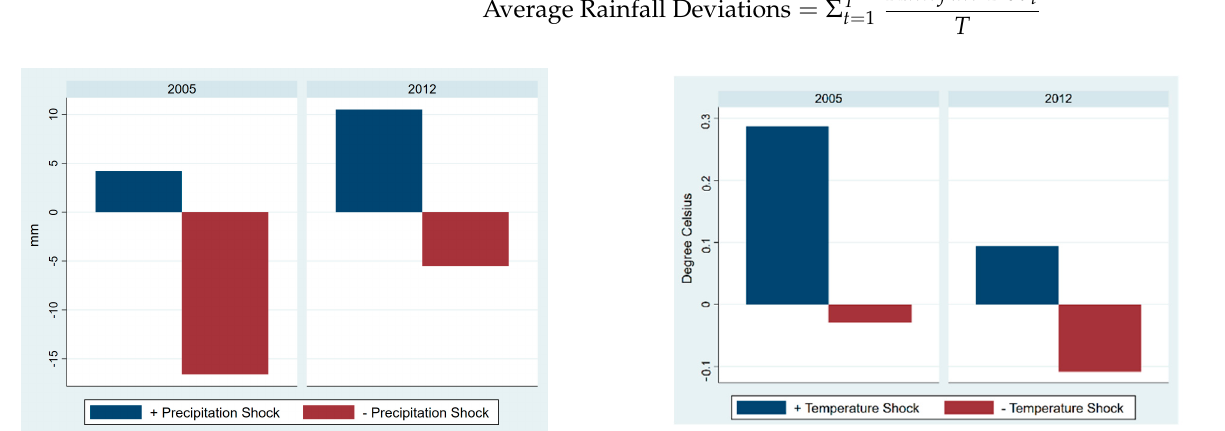
Figure 2. Annual deviations from the long-term rainfall patterns, across India, for 2005 and 2012. Left : The annual deviations (positive and negative) from the long-term precipitation patterns, across India, 2005 and 2012. Right: The annual deviations (positive and negative) from the long-term temperature patterns, across India, in 2005 and 2012.